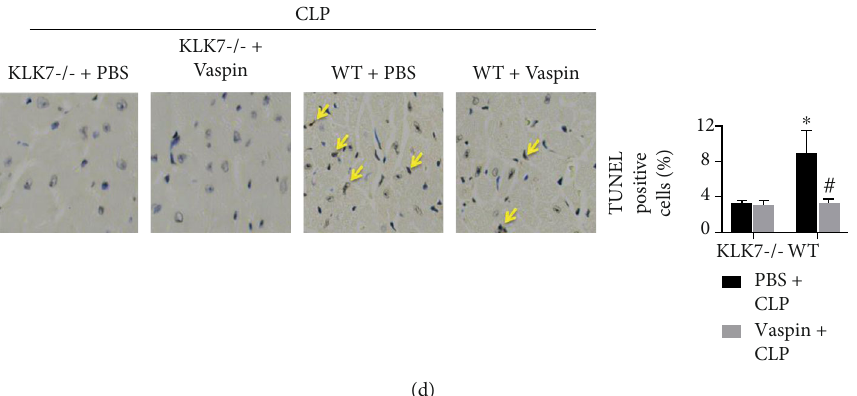
Figure 7: E ff ects of KLK7 deletion on cardiac in fl ammation and cardiomyocyte apoptosis in septic mice. (a, b) Levels of CD45+ cells and CD68+ cells, as well as the levels of the proin fl ammatory cytokines MCP-1, IL-6, IL-17, TNF- α , and IFN- γ in the heart (two-way ANOVA). Blue, green, and red indicate nuclei, CD45-positive cells, and CD68-positive cells, respectively. (c) The expression of cleaved caspase3 in LPS-treated WT cardiomyocytes and KLK7-/- cardiomyocytes was analyzed (two-way ANOVA). Blue and red spots indicate the nucleus and cleaved caspase3, respectively. (d) The number of TUNEL-positive cardiac cells was quanti fi ed (two-way ANOVA). ∗ p < 0 : 05 vs. the WT + PBS + CLP or WT + PBS + LPS group. ns p > 0 : 05 vs. the KLK7 − / − + PBS + CLP or KLK7 − / − + PBS + LPS